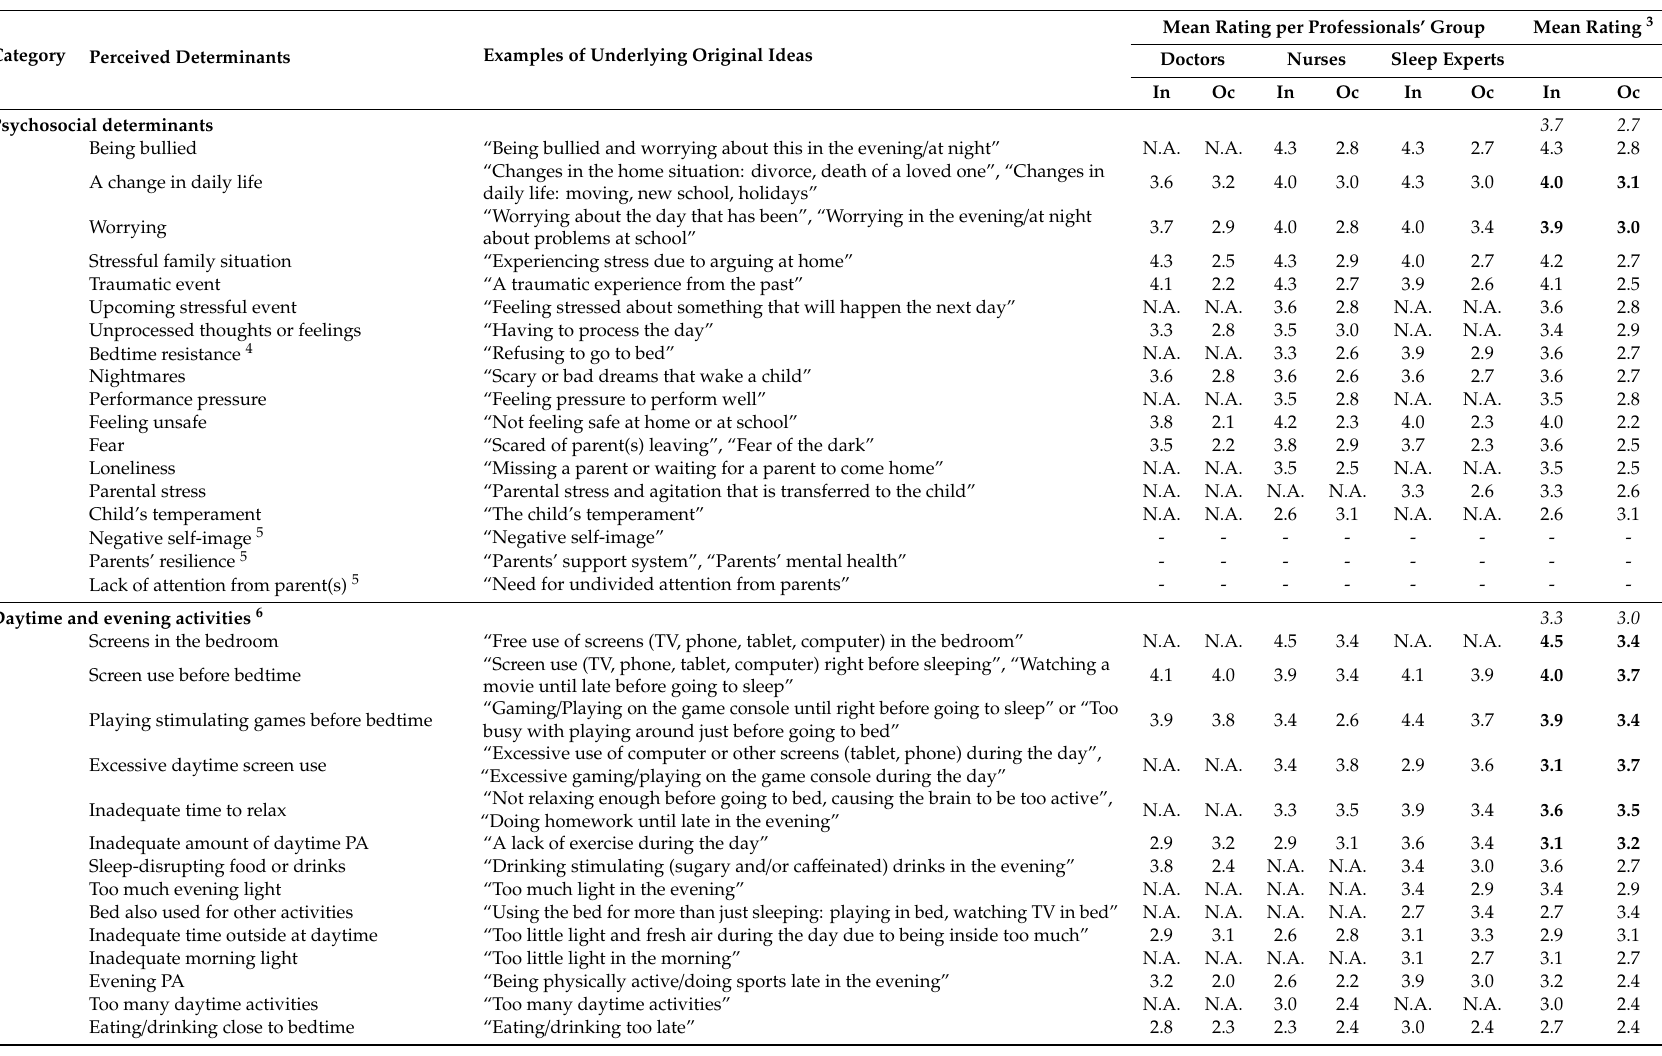
Table 2. Mean rating of influence on sleep 1 and occurrence in practice 2 for the professional-perceived determinants of children’s inadequate sleep. Category Perceived